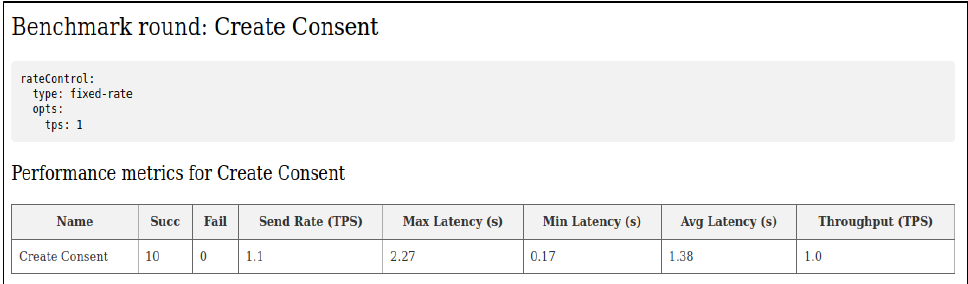
Figure 15. Docker file used for setting up the Hyperledger Caliper.